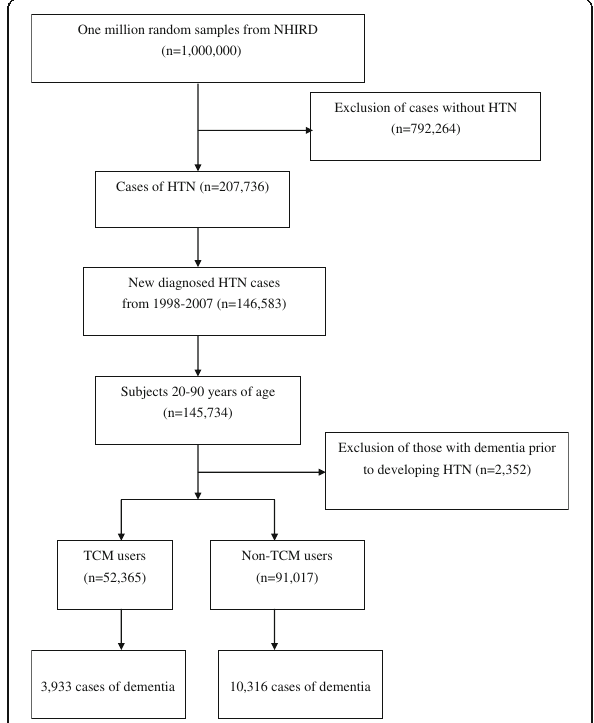
Fig. 1 A flowchart about the selection and follow-up of study